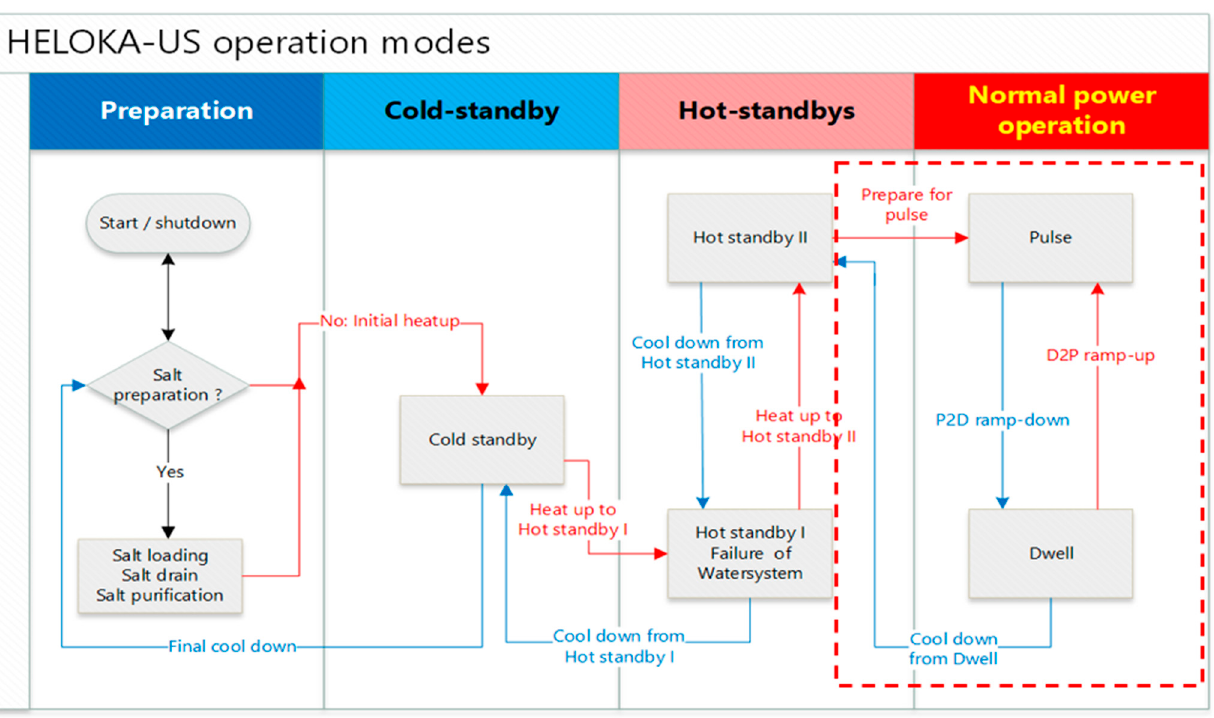
Figure 7. DEMO operational modes including all states and transitions. P2D: pulse-to-dwell transi- tion, D2P: dwell-to-pulse transition.